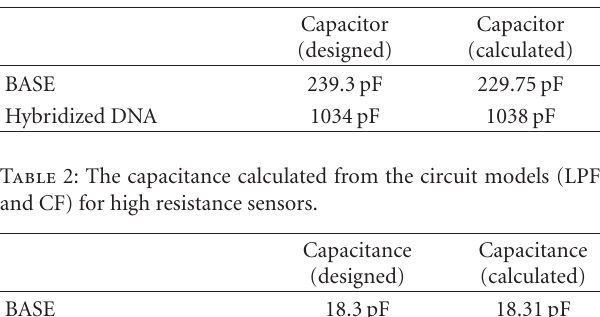
Table 1: The capacitance calculated from the circuit models (LPF and CF) for a low resistance sensor.